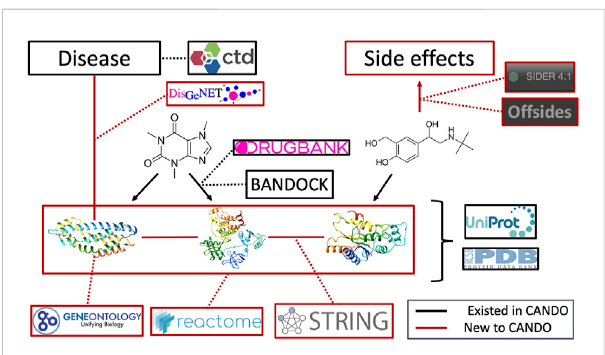
FIGURE 7 Overview of architecture and data sources for the heterogeneous network. Protein sequences and their x-ray structures were extracted from UniProt (UniProt Consortium, 2019) and the Protein Data Bank (Burley et al., 2019), which were connected to eachotherviaprotein-proteininteractionsfromtheStringdatabaseas well as to protein pathways from the Reactome database. Protein annotations to Gene Ontology (Gene Ontology Consortium, 2004; GeneOntologyConsortium,2015;GeneOntologyConsortium,2019) terms were extracted from UniProt as well. Proteins were mapped to indications using DisGeNET (Piñero et al., 2016). Drug/compound structures were downloaded from DrugBank (Wishart et al., 2017) in addition to known protein-drug interactions, which was further supplementedusingourBANDOCKinteractionscoringprotocol(Falls et al., 2019; Mangione et al., 2020a). Finally, adverse drug reactions, or drug side effects, were extracted from the SIDER (Kuhn et al., 2016) and OFFSIDES (Tatonetti et al., 2012) databases. Black signi fi es an already existing entity or relation in the CANDO platform, whereas red signi fi es a novel association for our current network-based study and constitutes the majority of connections between these